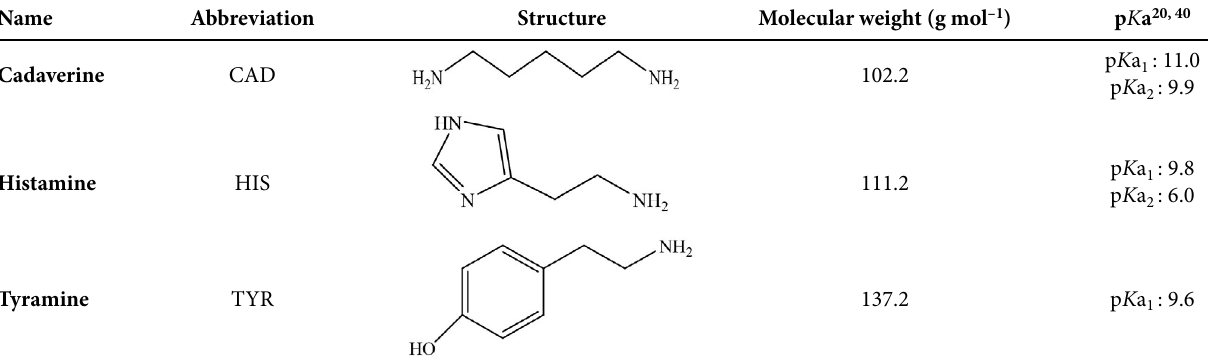
Table 1. Biogenic amines